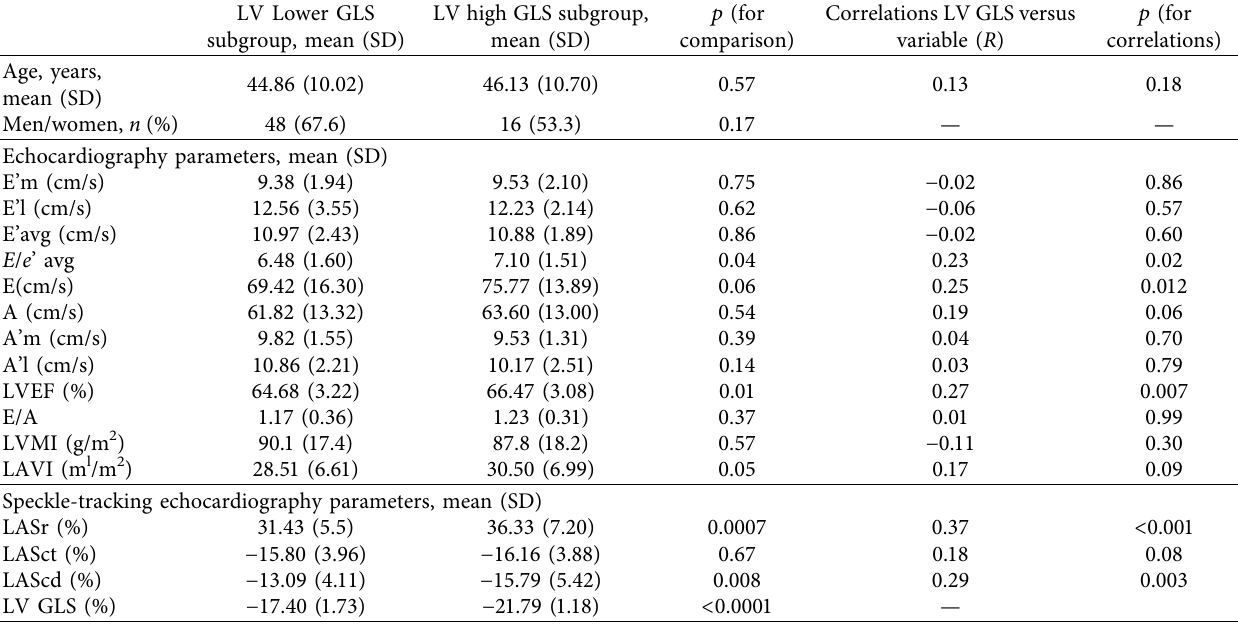
Table 3: The comparison between “High GLS” and the “Lower GLS” subgroups and correlations analysis between the LV GLS and other variables.